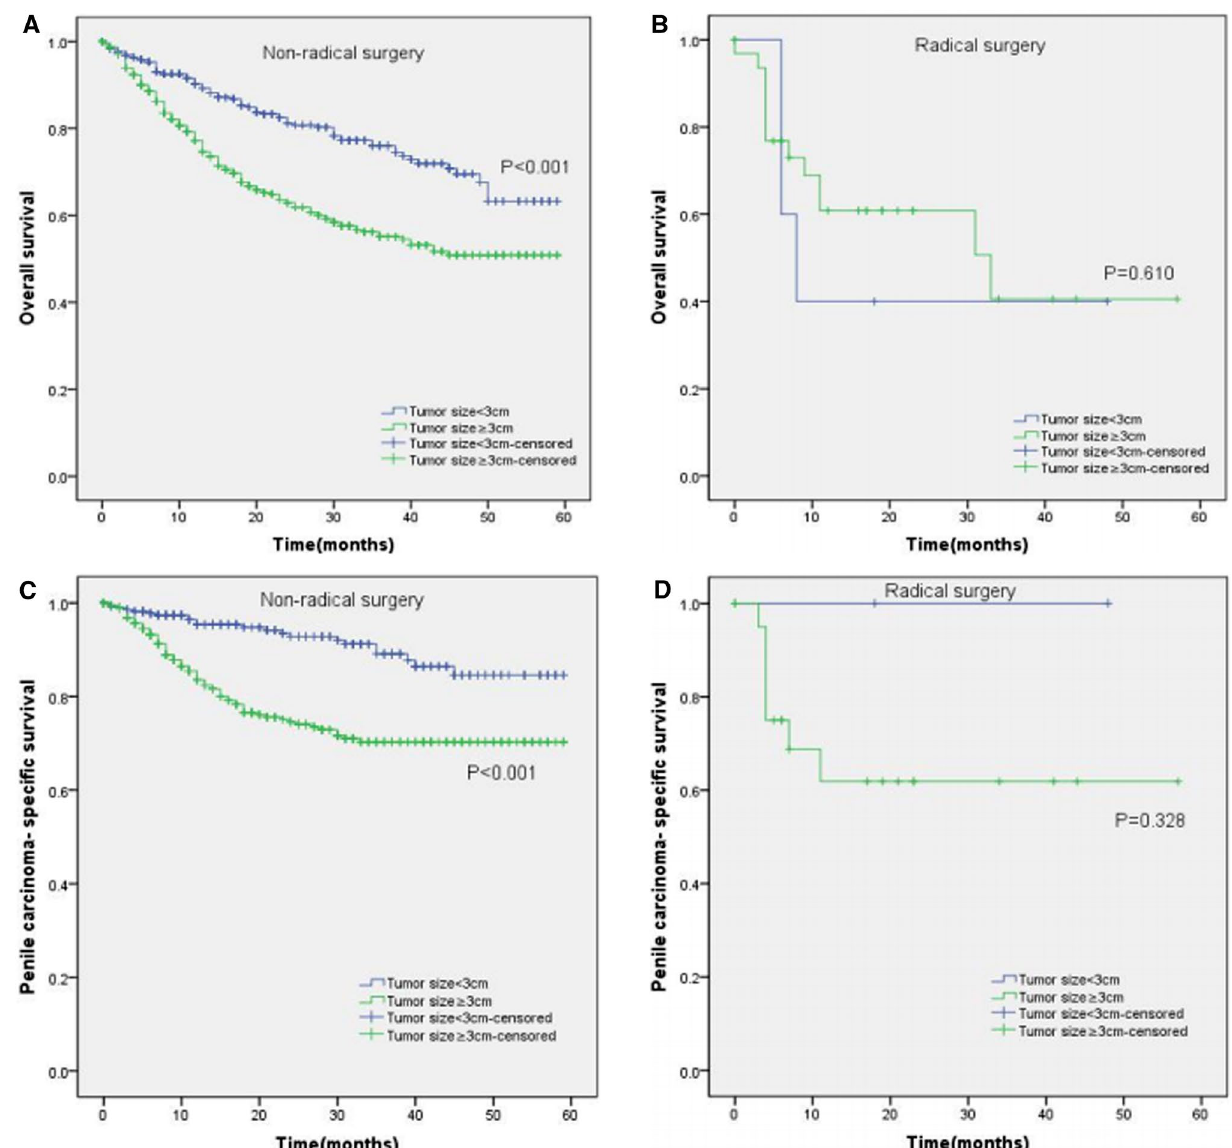
Fig. 8 Kaplan–Meier analyses of overall survival ( A , B ) and penile carcinoma-specific survival ( C , D ) between non-radical surgery group and radical surgery group in patients stratified by tumor